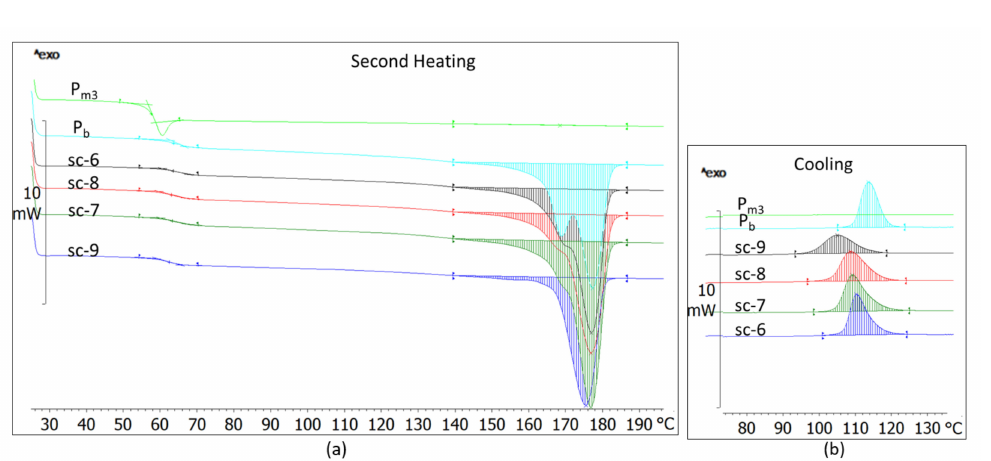
Figure 5. DSC thermograms of the sc-6, sc-7, sc-8 and sc-9 compounds and those of the compounded PLA grades (P b , Pm 3 ) after second heating (10 ◦ C/min) ( a ) and after cooling (2 ◦ C/min) ( b